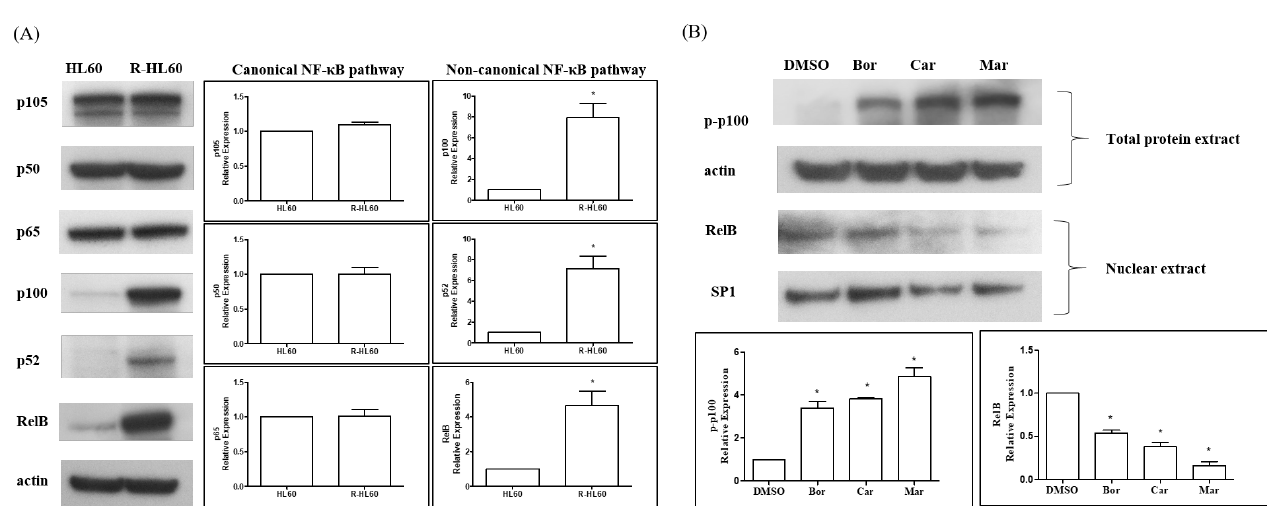
Figure 3. Proteasome inhibitors inhibited the activation of non-canonical NF- κ B signaling pathway in R-HL60 cells. ( A ) The protein expression of NF- κ B1 p105, p50, and p65 was not significantly different between HL60 and R-HL60 cells. In addition, the protein expression of NF- κ B2 p100, p52, and RelB was higher in R-HL60 than in HL60 cells. The paired t -test was applied to determine the differences between HL60 and R-HL60 cells. The data are represented as the mean ± standard error of three independent experiments, with * p < 0.05 indicating a statistically significant difference. ( B ) Proteasome inhibitors (200 nM bortezomib, carfilzomib, or marizomib) induced phosphorylated p100 in the total protein extract and reduced RelB expression in the nuclear extracts after proteasome inhibitor treatment for 4 h. The one-way ANOVA was used to determine the differences between the experimental and vehicle control (dimethyl sulfoxide) group and Newman-Keuls multiple com- parison test was applied as a post hoc test. The data are represented as the mean ± standard error of three independent experiments, with * p < 0.05 indicating a statistically significant